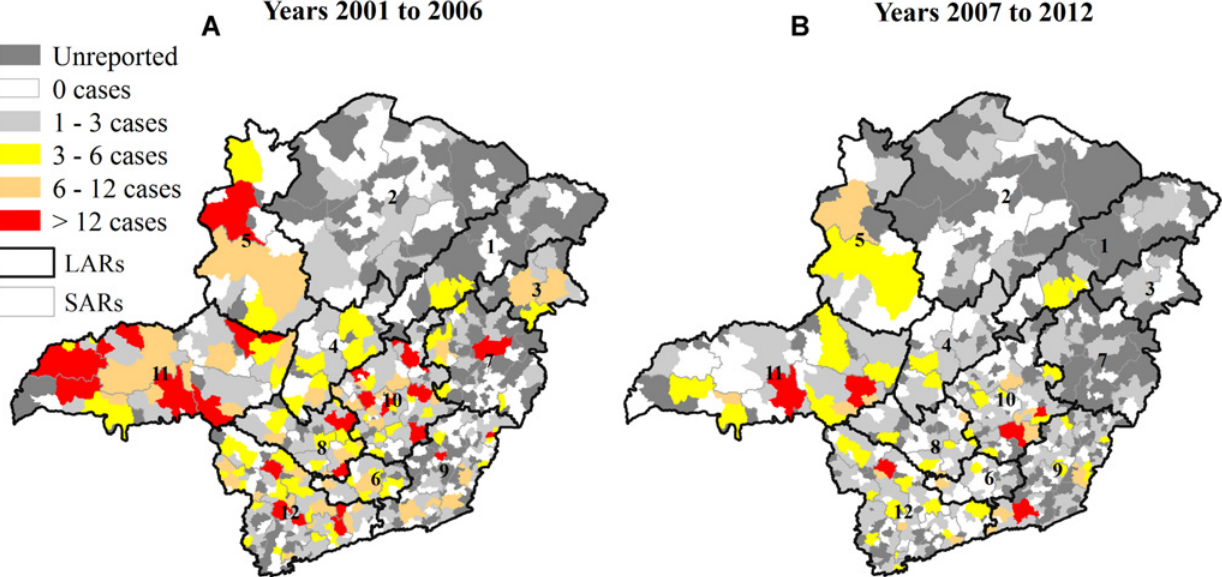
Fig 3. Spatial distribution of positive diagnoses of animal rabies in the first (A) and second (B) study periods by municipality in Minas Gerais, Brazil, from 2001 to